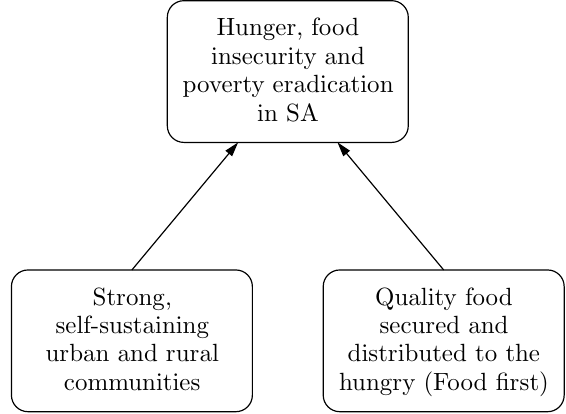
Figure 1: A causal map of the overall goals as outlined by